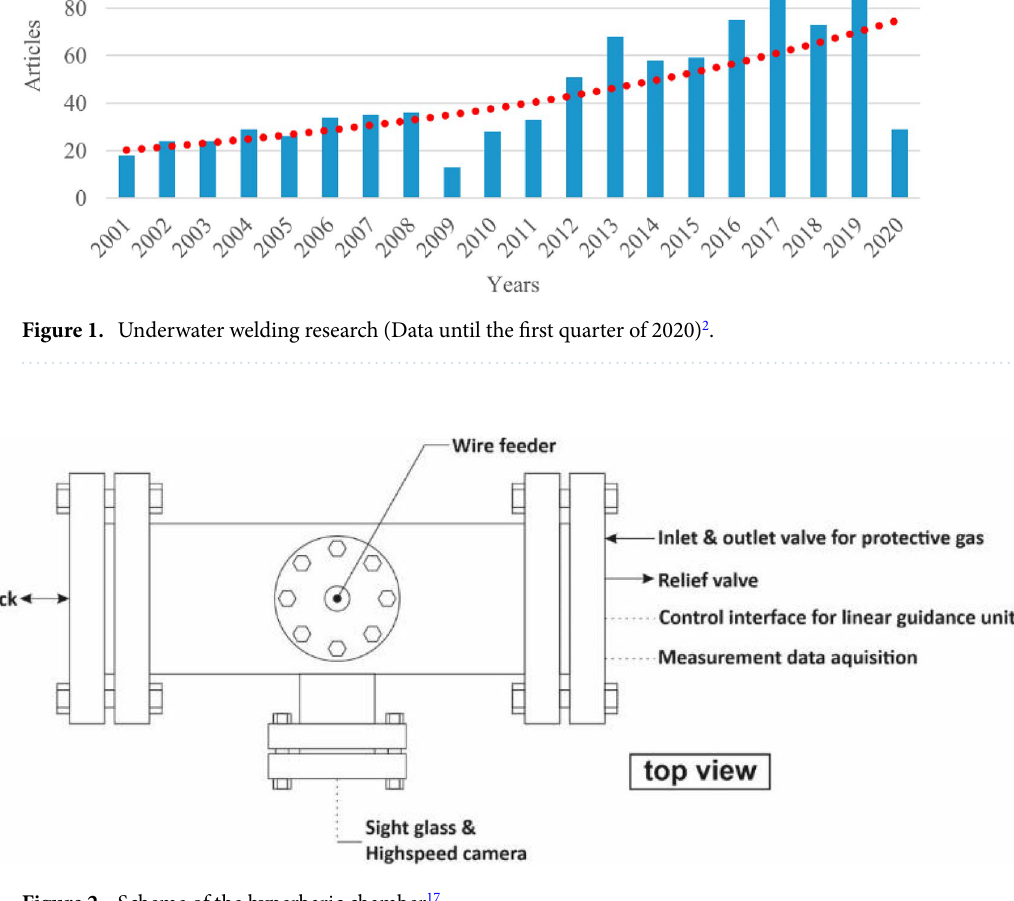
Figure 2. Scheme of the hyperbaric chamber 17